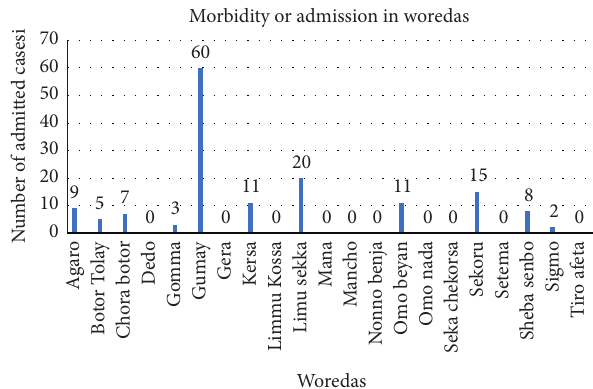
Figure 6: Distribution of typhoid fever morbidity on admission by woredas of the Jimma Zone, Oromia Region, Southwest Ethiopia.